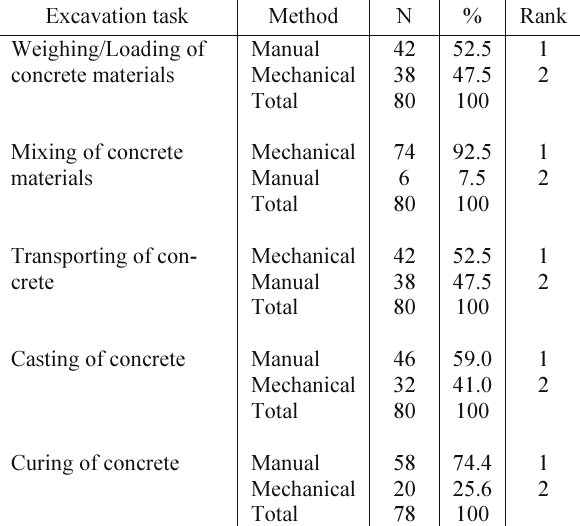
Table 2. Levels of mechanization of tasks in concrete